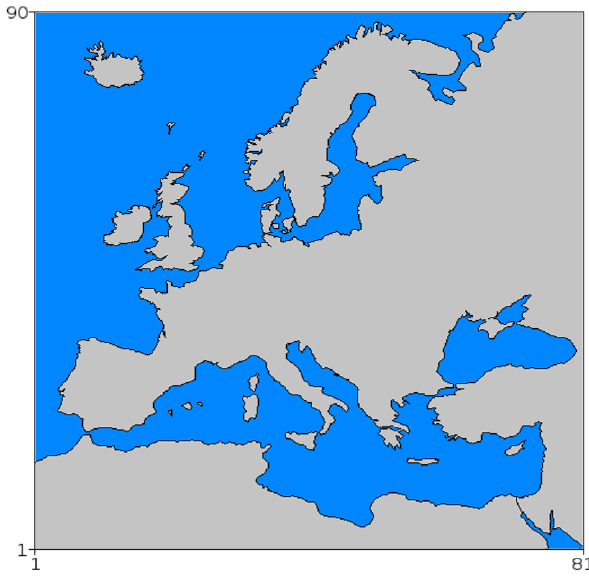
Fig. 2. Modelling domain used for CTM calculations with 54 × 54km 2 grid resolution and 30 vertical layers.